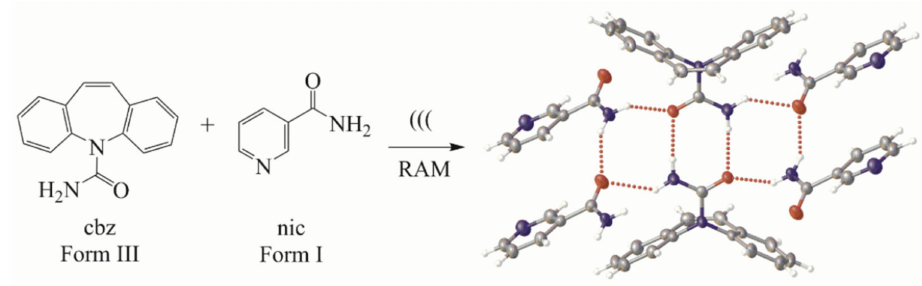
Figure 14. Cocrystal formation of cbz:nic 1:1 (CSD refcode: UNEZES; P2 1 /n) using